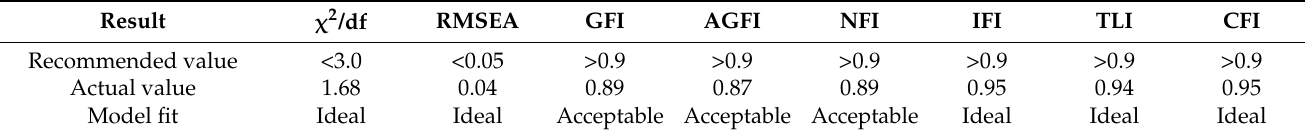
Table 8. Fitting results of the